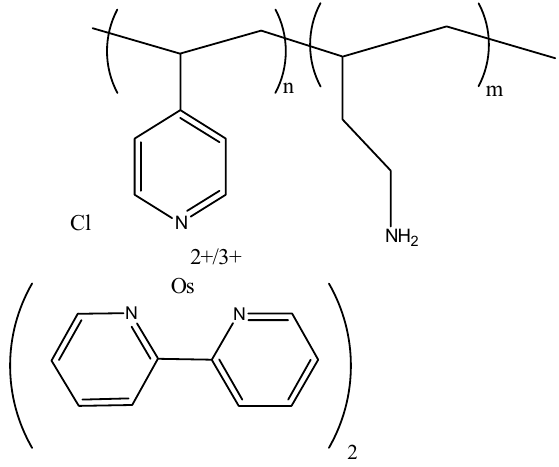
Figure 1. Structure of the polycationic redox polymer used in these